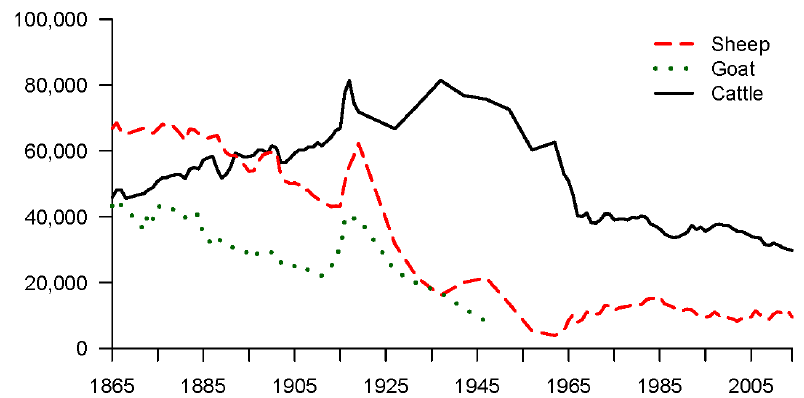
Figure 8. Illustration of the change in number of cattle, sheep and goats in Jämtland, from 1865 until 2014. From 1947 onward there are no records on the number of goats. Solid black line represents cattle, red dashed line represents sheep and green dotted line represents goats. Sources: Regional Agricultural Societies and Statistics Sweden.